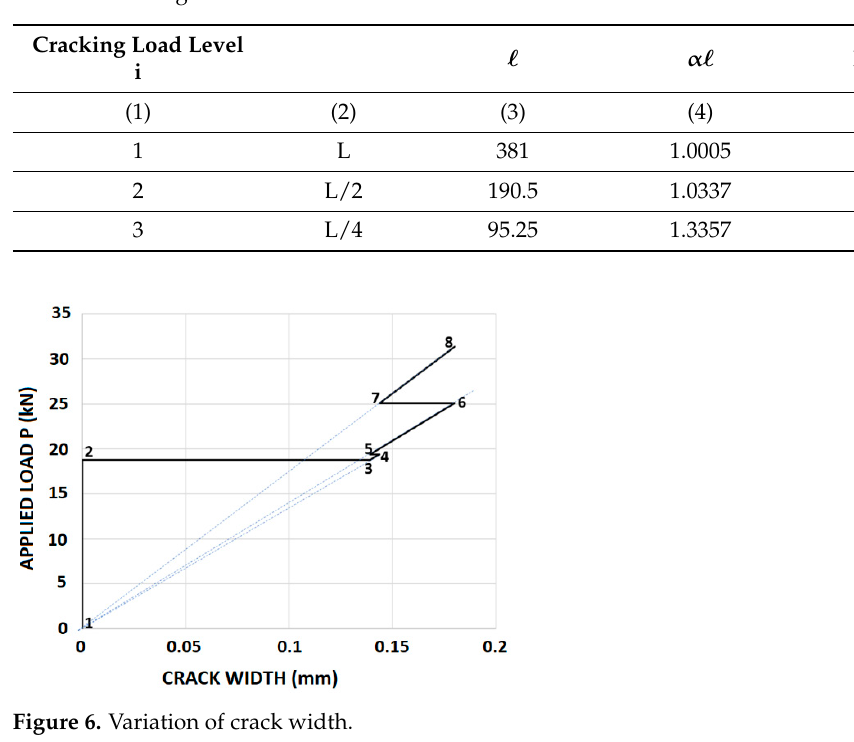
Figure 5. Amplification factor. Table 2. Cracking loads.